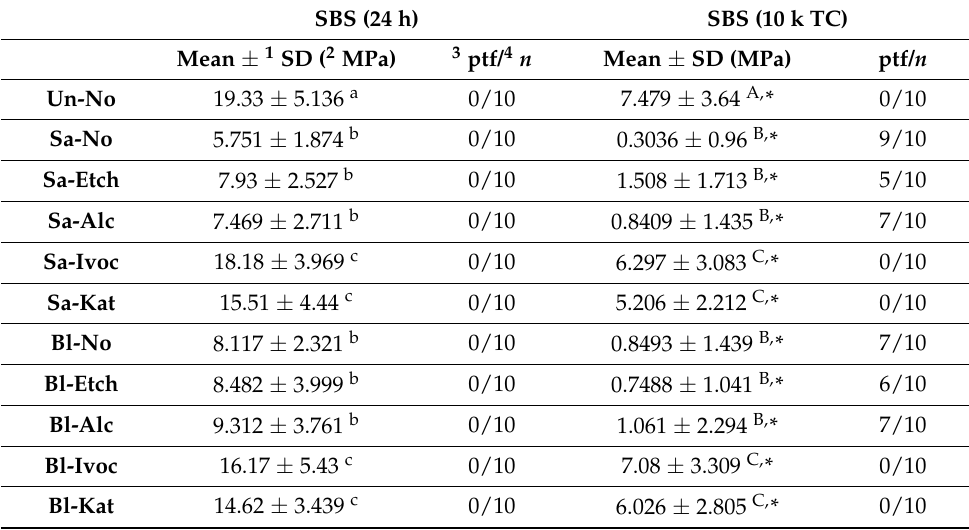
Table 3. Mean ± standard deviation (SD) shear bond strength (SBS) expressed in mega Pascal (MPa) for the different contamination and decontamination groups at 24 h and after thermocycling (TC). SBS (24 h)